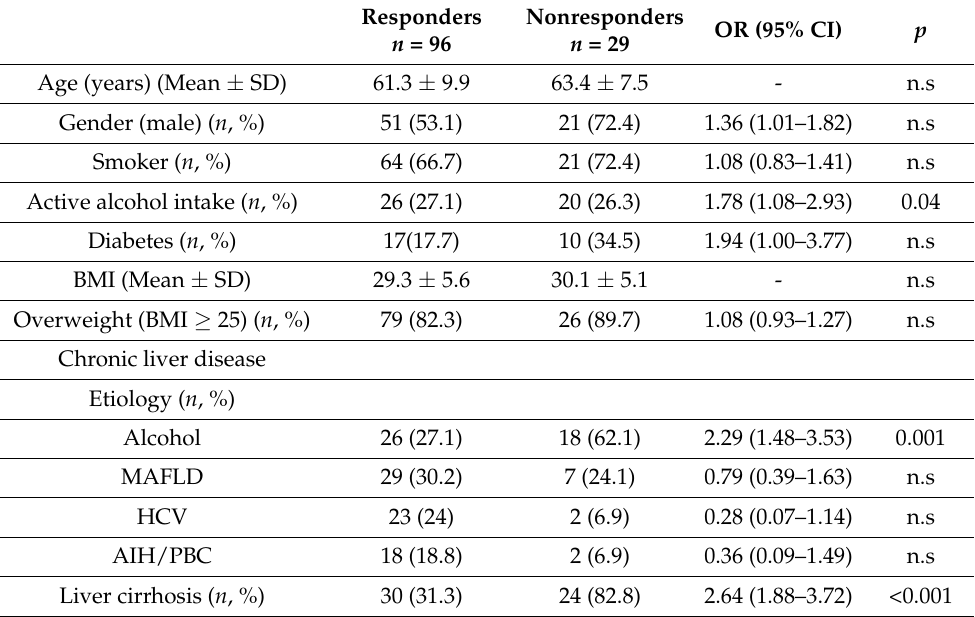
Table 2. Comparison of patient characteristics between responders and nonresponders to HBV vaccination by univariate